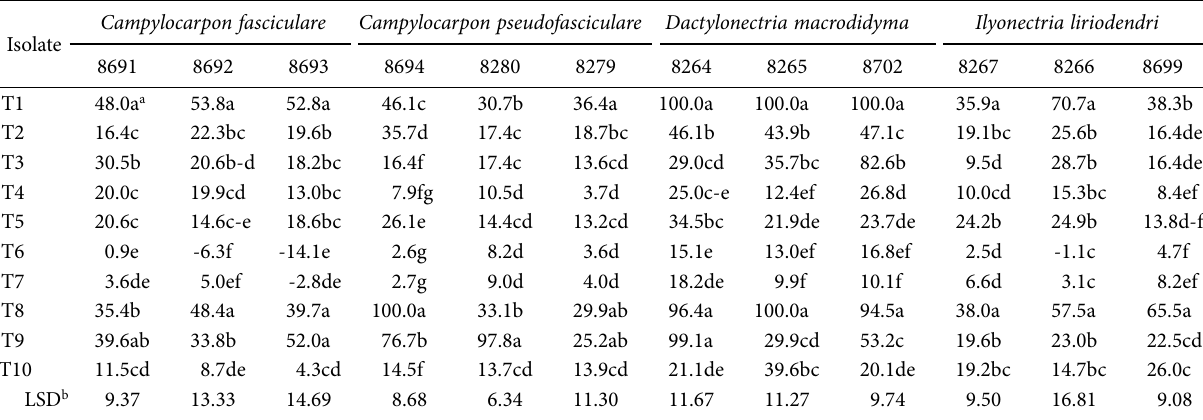
Table 3. Mean percentage of mycelium growth inhibition of four species of black foot disease pathogens (three isolates each) from diffusible